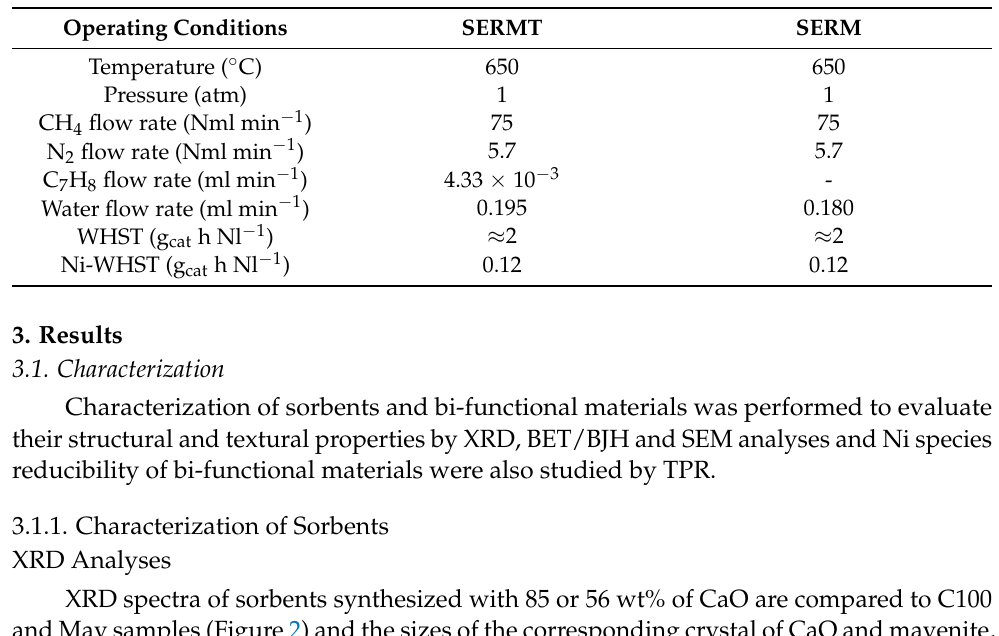
Table 2. Operating conditions of SERMT and SERM.